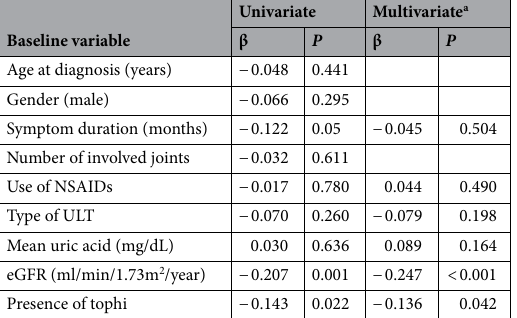
Table 5. Linear regression analysis for eGFR decline in study patients. NSAID non-steroidal anti- inflammatory drugs, ULT urate lowering therapy, eGFR estimated glomerular filtration rate. a Adjusted